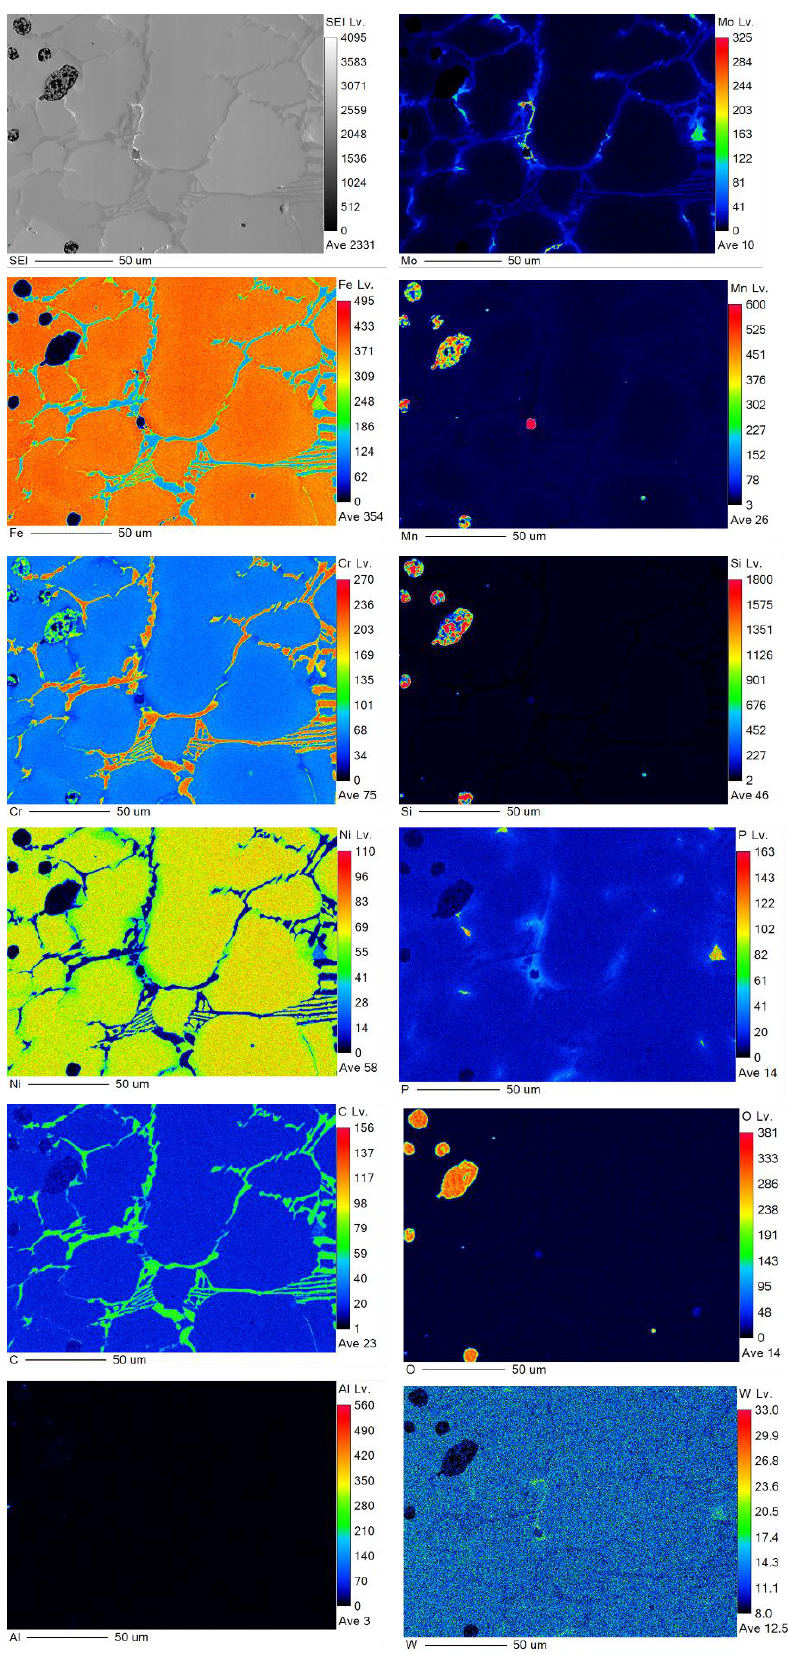
Figure 13. WDX measurement for the refractory ballast sintered for 240 s, mapping Fe, Cr, Ni, Mo, Mn, Si, P, C, O, Al, and W.